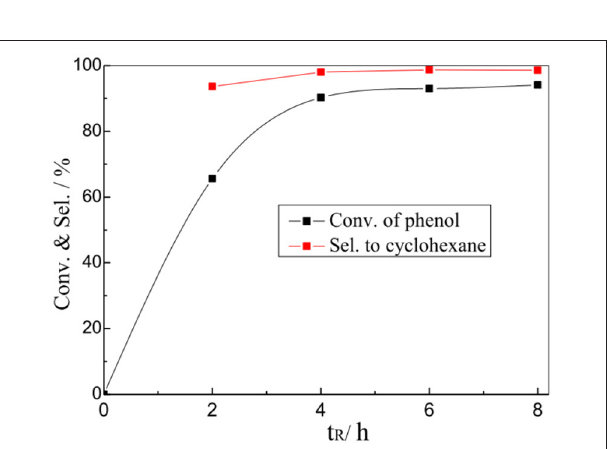
FIGURE 7 | Effect of n Pt /n PhOH on the HDO of phenol over 1%Pt/SBA-Pr. Reaction conditions: P H2, 4.00 MPa; T R , 200 ◦ C; 800 rpm, t R , 4h.